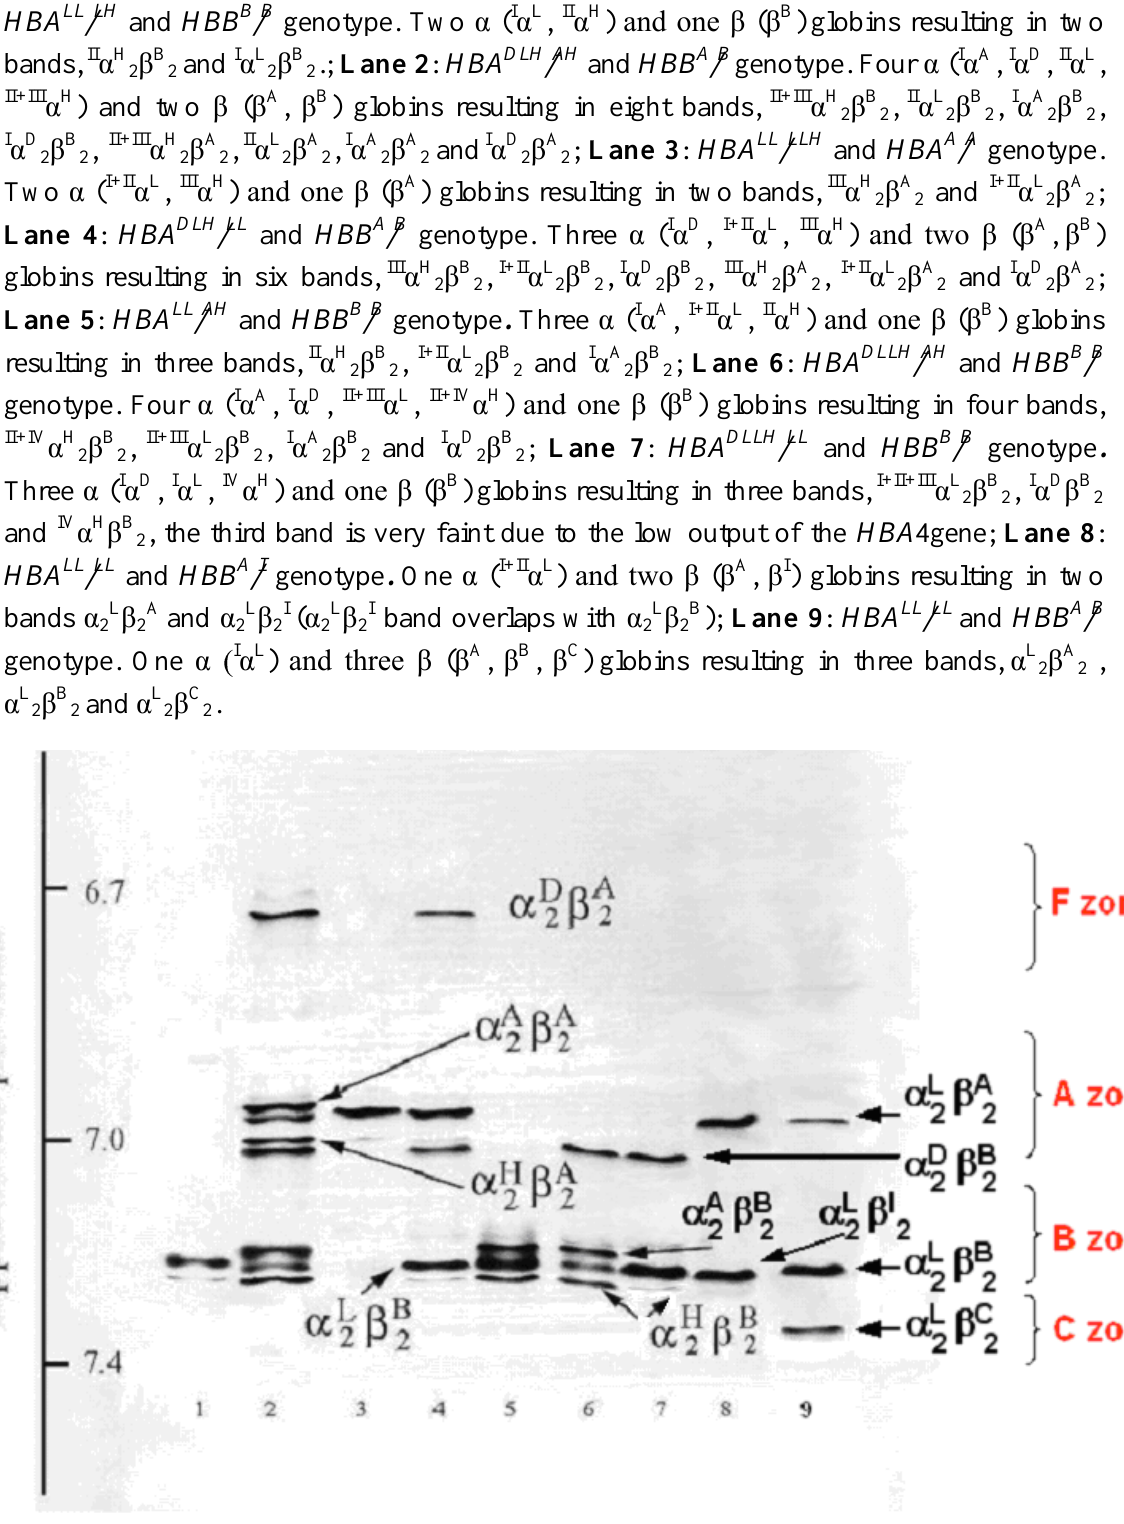
Figure 3. Polyacrylamide gel isoelectric focusing (PAGIF) showing adult Hb band patterns in Apulian sheep carrying different α and β globin chains. Lane 1